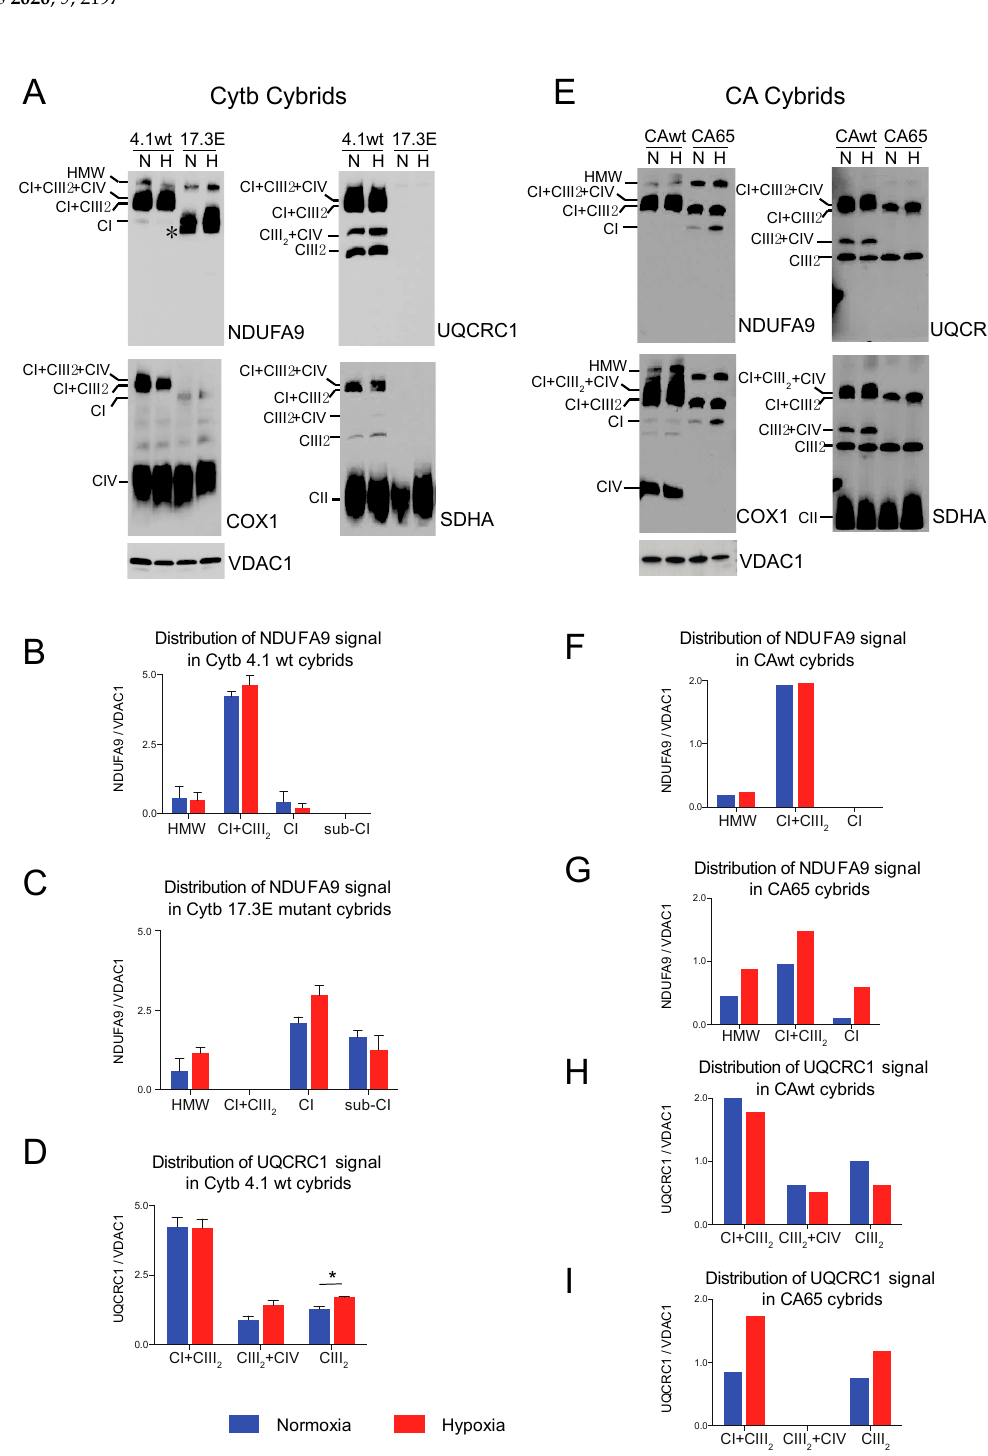
Figure 4. Effect of hypoxia in stability of respiratory complexes in human cybrids with defects in CIII and CIV. ( A ) Cytochrome b cybrids: control wild type (Cytb 4.1wt) and cybrid carrying a homoplasmic 4 base pair deletion in the CYTB gene of the mtDNA (Cytb 17.3E) were exposed to normoxia (N, 21% oxygen) or hypoxia (H, 1% oxygen) for 24 h and mitochondrial proteins were extracted with digitonin and OXPHOS complexes and SCs analyzed by BN-PAGE followed by Western blot using antibodies against respiratory complex subunits. The positions of each respiratory complex, SCs (HMW, CI + CIII 2 + CIV, CI + CIII 2 , CIII 2 + CIV) and molecular weight markers are indicated in the figure. Cytb 17.3E cybrids in normoxia display a fast migrating band with the NDUFA9 antibody corresponding to an assembly intermediate (* or Sub-CI) of about 830 kDa, when exposed to hypoxia this band migration is retarded indicating the presence of fully assembled CI. ( B , C ) Quantification and distribution of NDUFA9 (CI subunit) and in 4.1wt and 17.3E cybrids